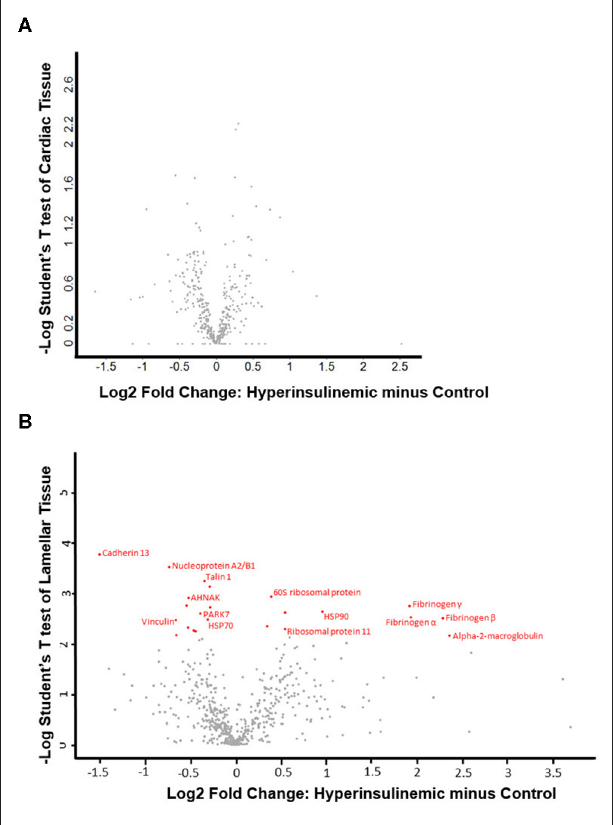
FIGURE 2 | Volcano plots of (A) cardiac tissue and (B) lamellar tissue of control and hyperinsulinemic horses. Significantly differentially expressed proteins (using an FDR of 0.05) are identified in red, with the corresponding protein identification ( n =